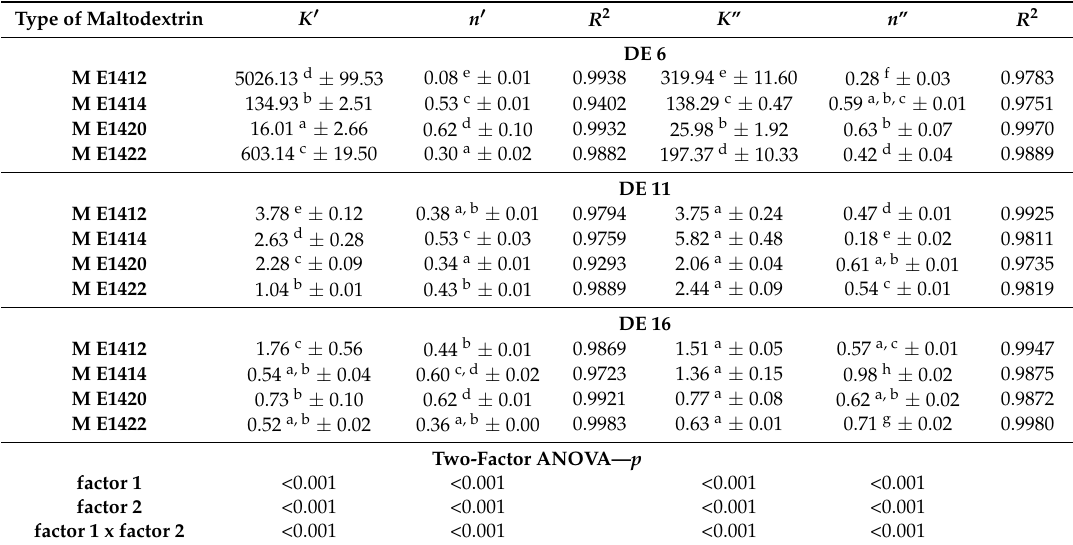
Table 4. Parameters of power model applied to describe mechanical spectra obtained for emulsions stabilized by 50% maltodextrin